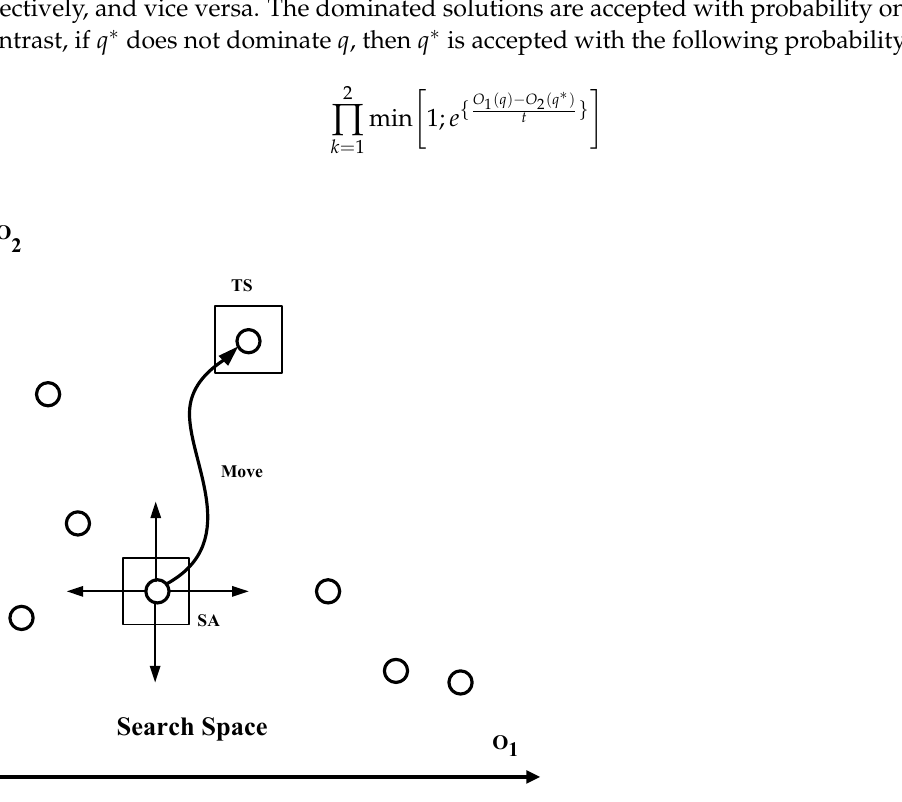
Figure 2. Search process in HTSA.